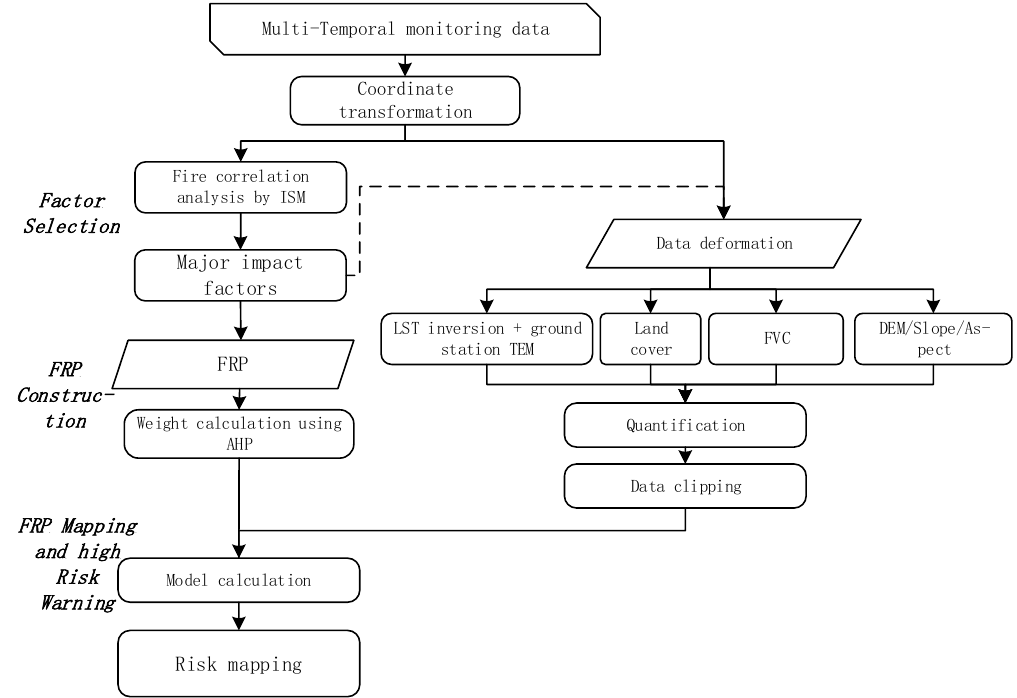
Figure 1 . Overall workflow for FRP modelling and evaluating of